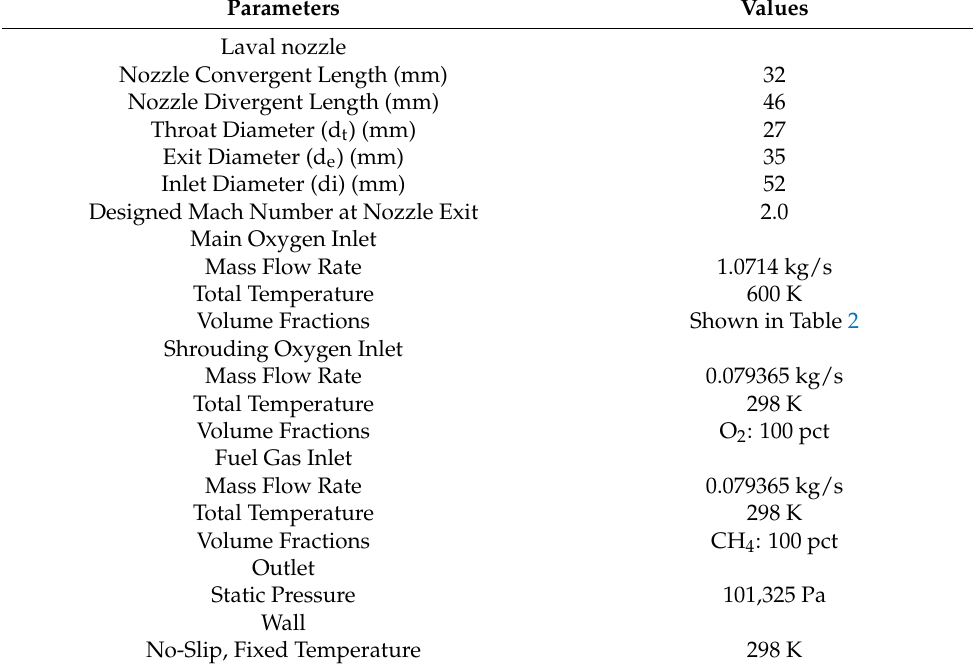
Table 1. Boundary conditions.